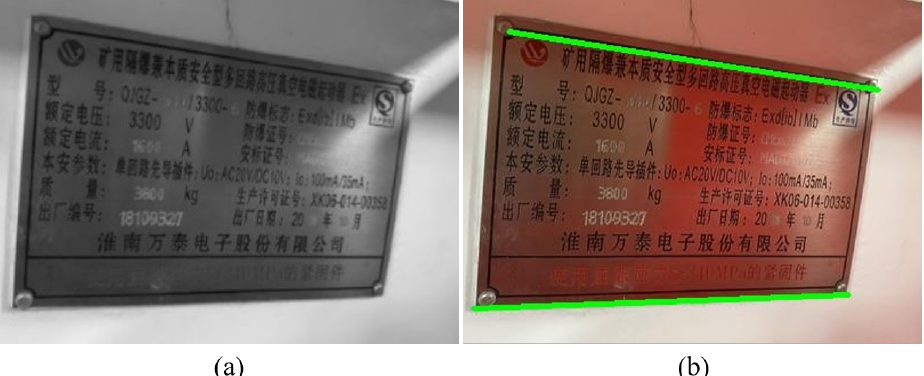
Figure 5. ( a ) Display of grayscale diagram. ( b ) The position of the original picture after enlargement and positioning. The figures describe the process of extracting the four coordinates by using the two longest line segments for edge detection. To reduce irrelevant features, only grayscale images are suitable for this